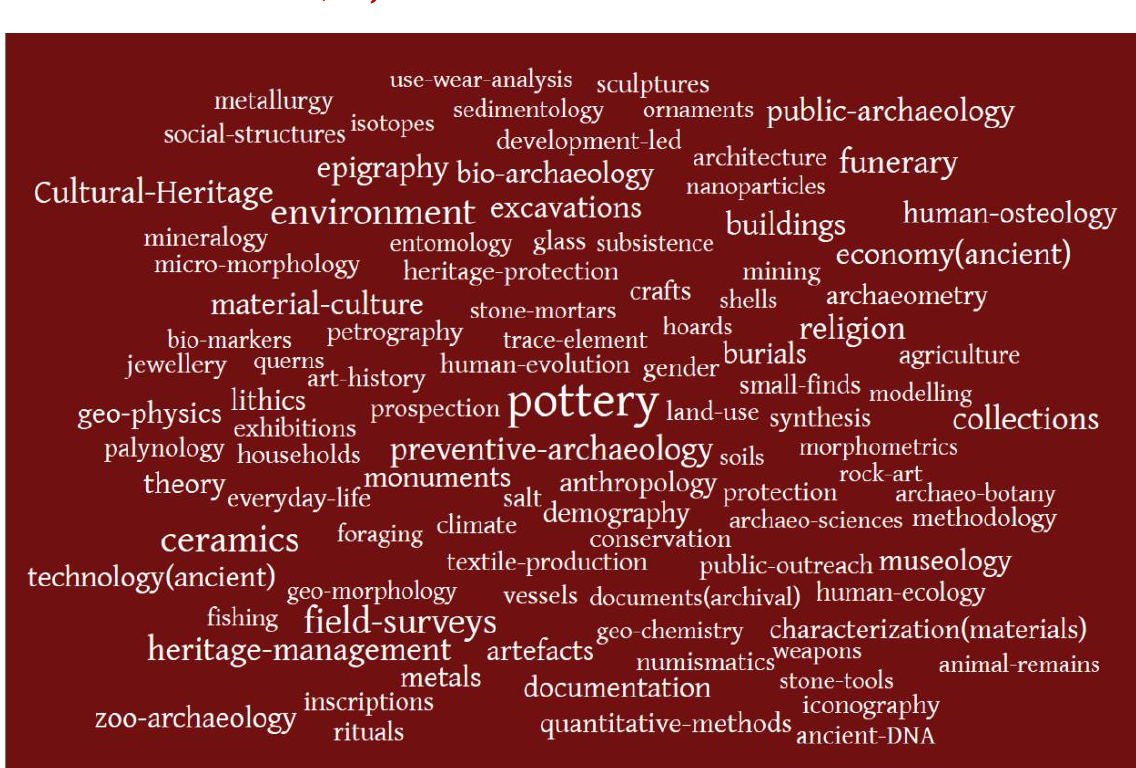
Figure 2 : Word cloud of 100 terms for research fields, objects and